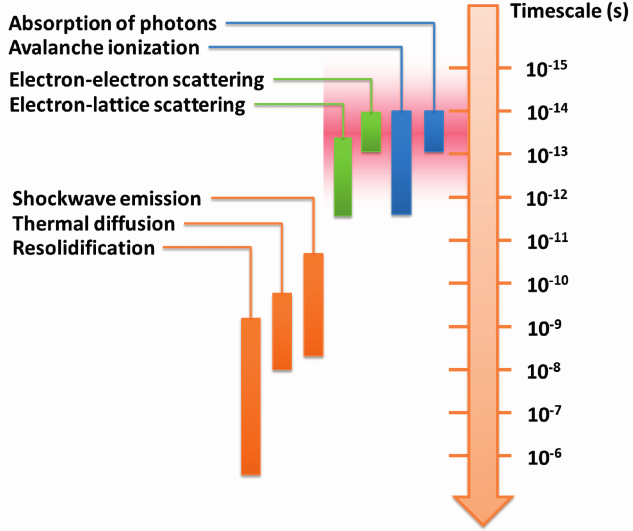
Figure 1. Typical timescales during interaction of ultrashort laser pulses with transparent